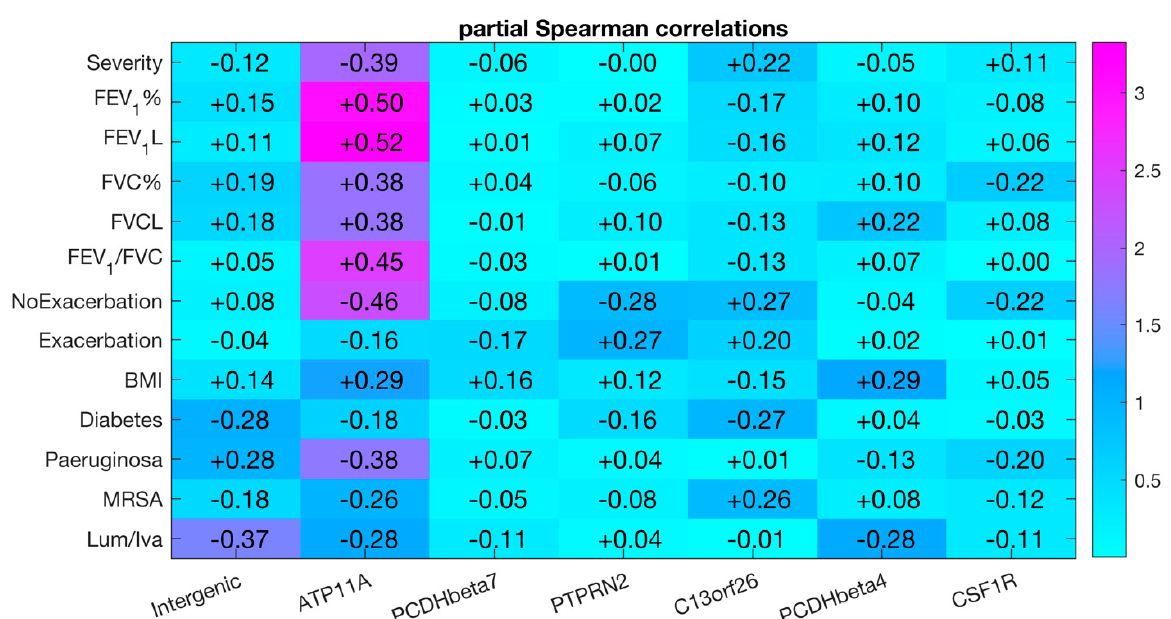
Age and sex adjusted Spearman correlations between DNA methylation and FEV 1 %. † β ( β ) values from 450 K array, where 1 corresponds to full methylation and 0 to no methylation. ∆β = median β mild CF patients-median β severe CF patients. § Wilcoxon’s test.